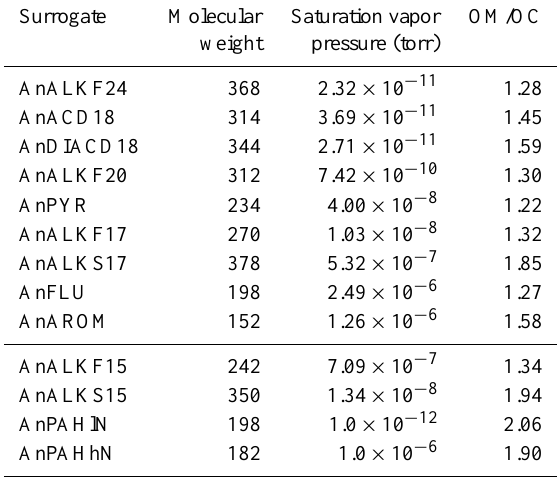
Table 3. Properties of the different surrogate secondary SVOC species formed from primary SVOC oxidation (top panel) and IVOC oxidation (bottom